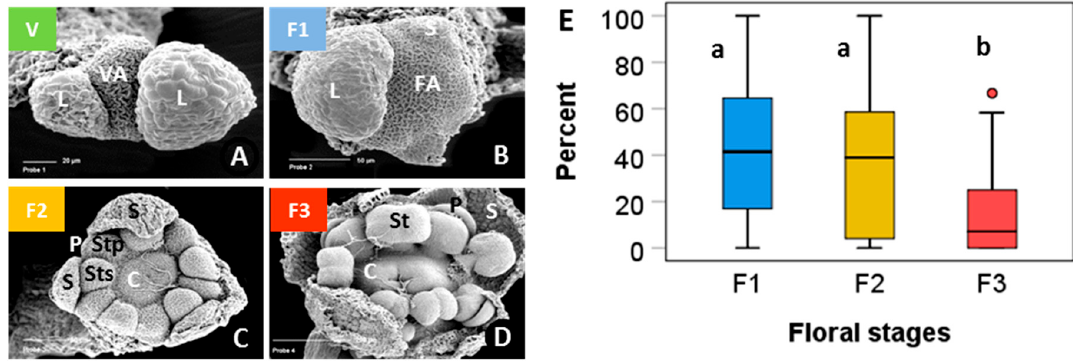
Figure 6. Saxifraga bryoides L. Bud stages in winter-dormant individuals at the time of the freezing experiments; green: vegetative (V); blue: early floral stages (F1); yellow: middle floral stages (F2); red: late floral stages (F3). ( A ) Vegetative shoot apex (VA) with leaf primordia (L) in alternate position; ( B ) floral apex (FA) shortly after the transition from vegetative to floral; the apical dome has flattened and sepal primordia (S) have emerged; ( C ) sepal and petal (P) primordia and two whorls of stamens in episepal (Sts) and epipetal (Stp) position have formed; carpel (C) margins appear as a crater-like structure. ( D ) Stamen (St) primordia have started to differentiate into filaments and anthers, carpels are forming a cone. Sepals that had begun to conceal the flower within were partly removed. ( E ) Percentage range of floral buds in different stages per individual; for details on the boxplot see Figure 1H; different lowercase letters indicate statistical differences among floral stages ( n = 44 individuals; S1, S2 > S3, p ≤ 0.001, one-way